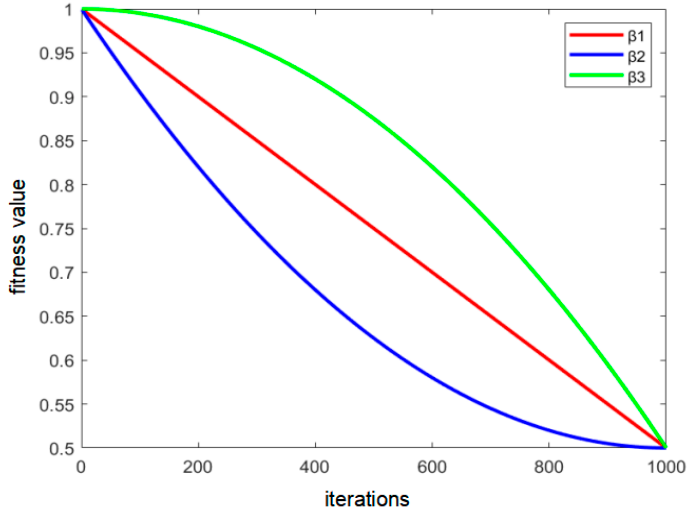
Figure 8. Diagram of the decreasing function.